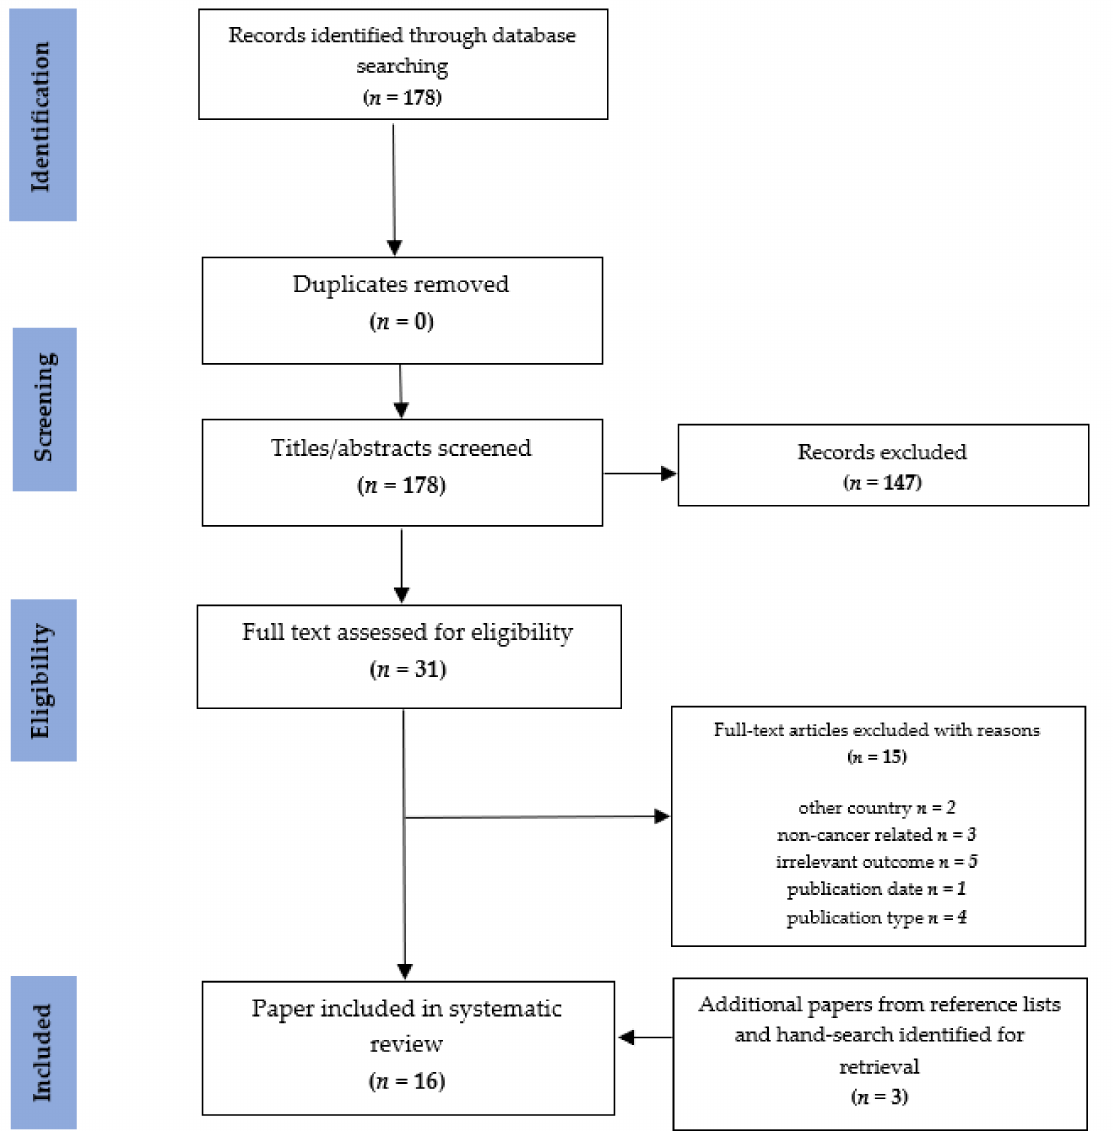
Figure 1. Preferred Reporting Items for Systematic Reviews and Meta-Analyses of the study selection